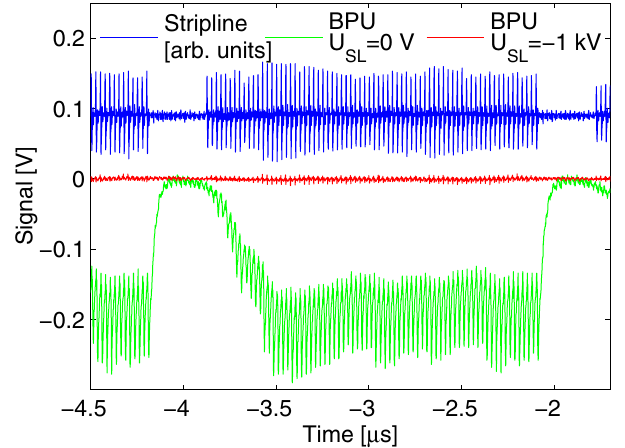
FIG. 8. (Color) The electron cloud was suppressed below the detection limit for large enough clearing voltages, e.g. U SL ¼ (cid:5) 1 kV , data from BPU 2 are